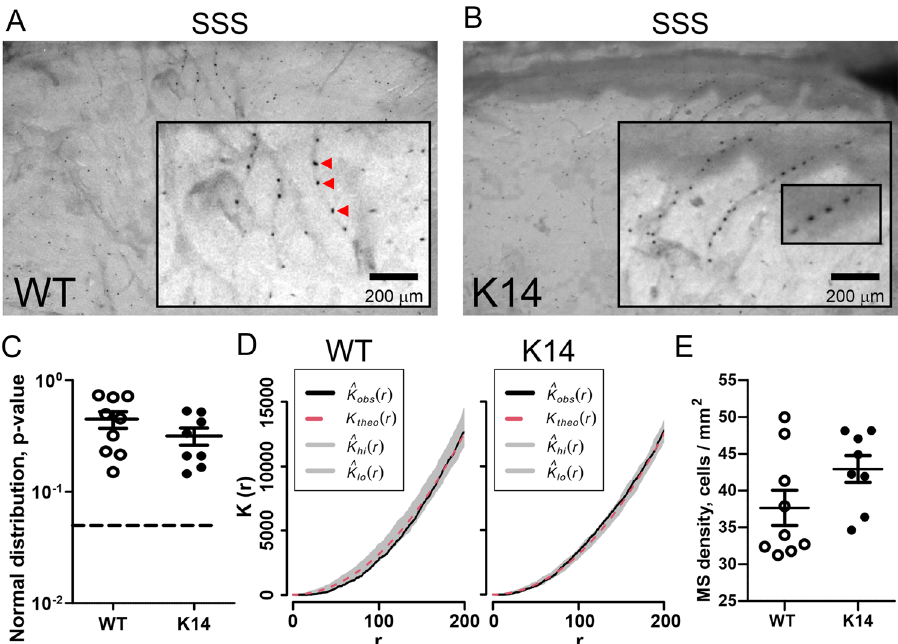
Figure 1. Dural mast cell population in WT and K14 mice. Mast cells localize in meninges of both WT ( A ) and K14 mice ( B ). Note the presence of mast cells (red triangles) aligned along putative meningeal blood vessels, afferent to the superior sagittal sinus (SSS, located at the top of the figure). ( C ) Mast cell normal distribution was tested using quadrat test, and the associated Gaussian p value was plotted for each mouse (WT n = 9, K14 n = 8; t(15) = 1.334, p = 0.2 by unpaired Student’s t-test). p values > 0.05 (dotted line) do not support the rejection of the hypothesis of Gaussian distribution. ( D ) Representative graphs showing the mast cell distribution, as calculated using the Ripley k-function. Of note, the function output is within the range of the Monte-Carlo envelope, which indicates random distribution. ( E ) Mast cell density (cells/mm 2 ) was counted in WT and K14 animals. Transgenic animals show a non-significant increase in the number of mast cells (WT n = 9, K14 n = 8; t(15) = 1.717, p = 0.11 by unpaired Student’s